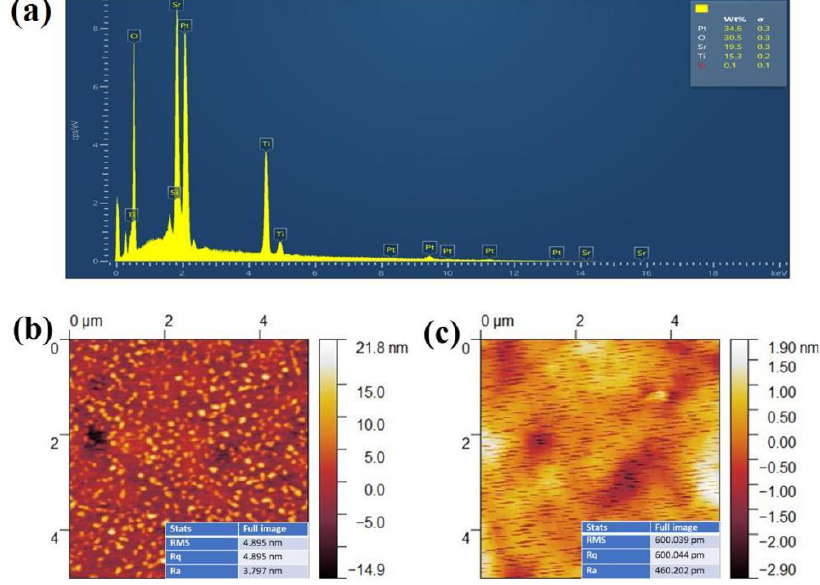
Figure 4. ( a ) Quantitative elemental EDS spectra and ( b , c ) AFM surface morphologies of the STO thin films annealed at ( b ) 650 °C and ( c ) 750 °C.